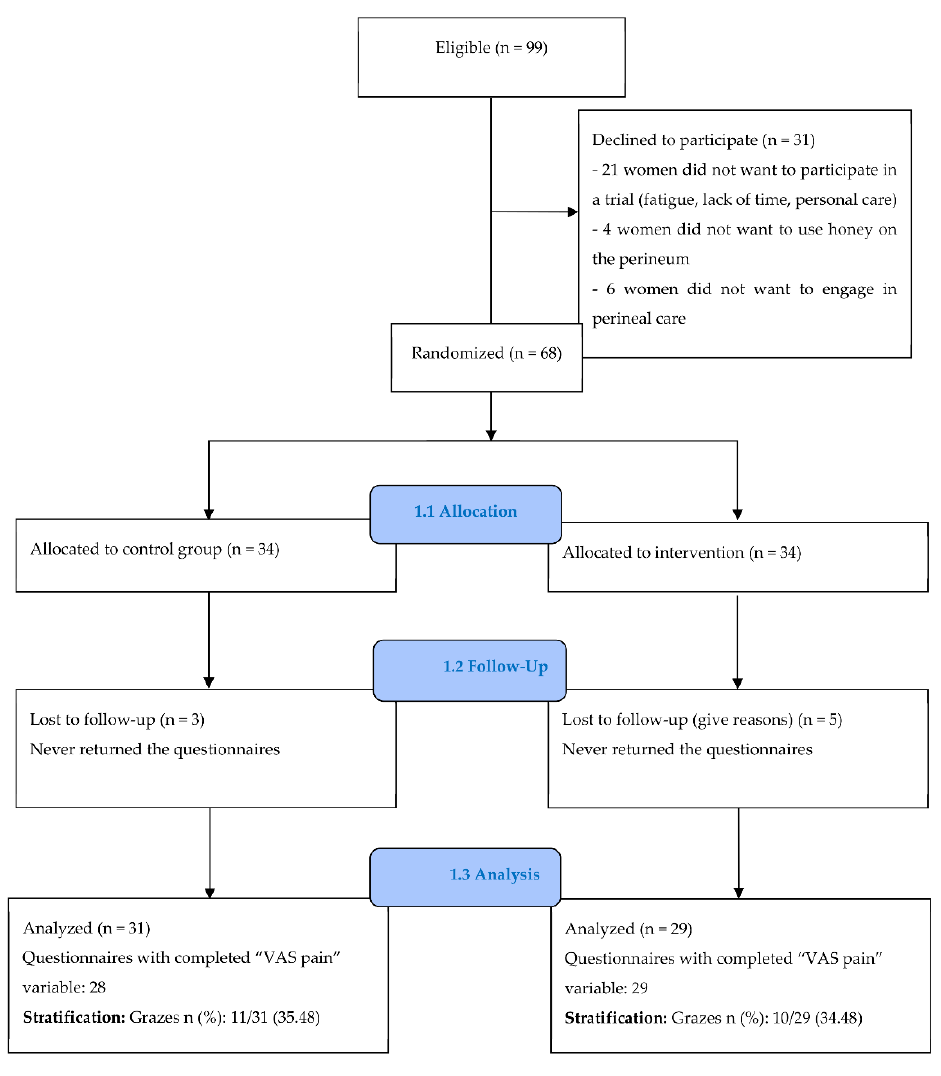
Figure 1. CONSORT flow chart. Table 1. Baseline sociodemographic and clinical characteristics .